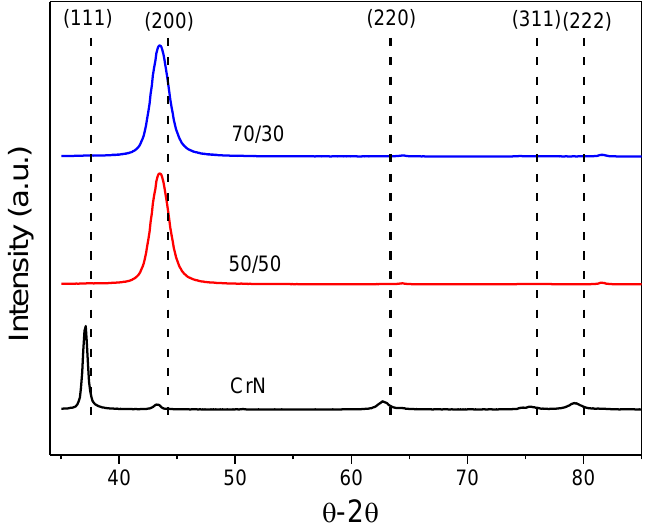
Figure 3. θ –2 θ XRD measurements from coatings showing strong dependency on Al presence. Peaks position is related to the B1-CrN structure (ICDD 00-001-0065 reference).